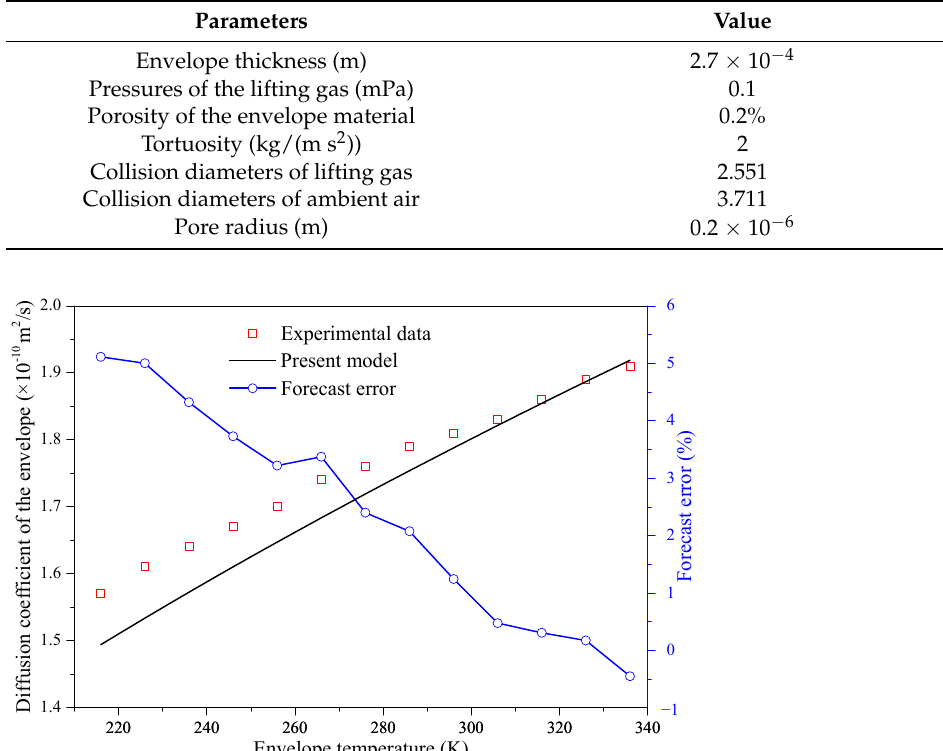
Table 3. Main parameters of the aerostat used for the simulation.